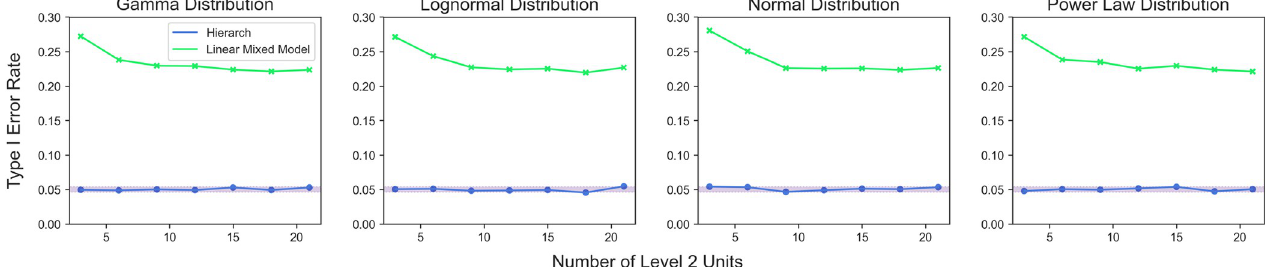
Fig 14. Type I error rate for a hierarchical randomization test based on the studentized covariance and a linear mixed model. Shaded area represents the 95% binomial confidence interval around a 5% type I error rate.